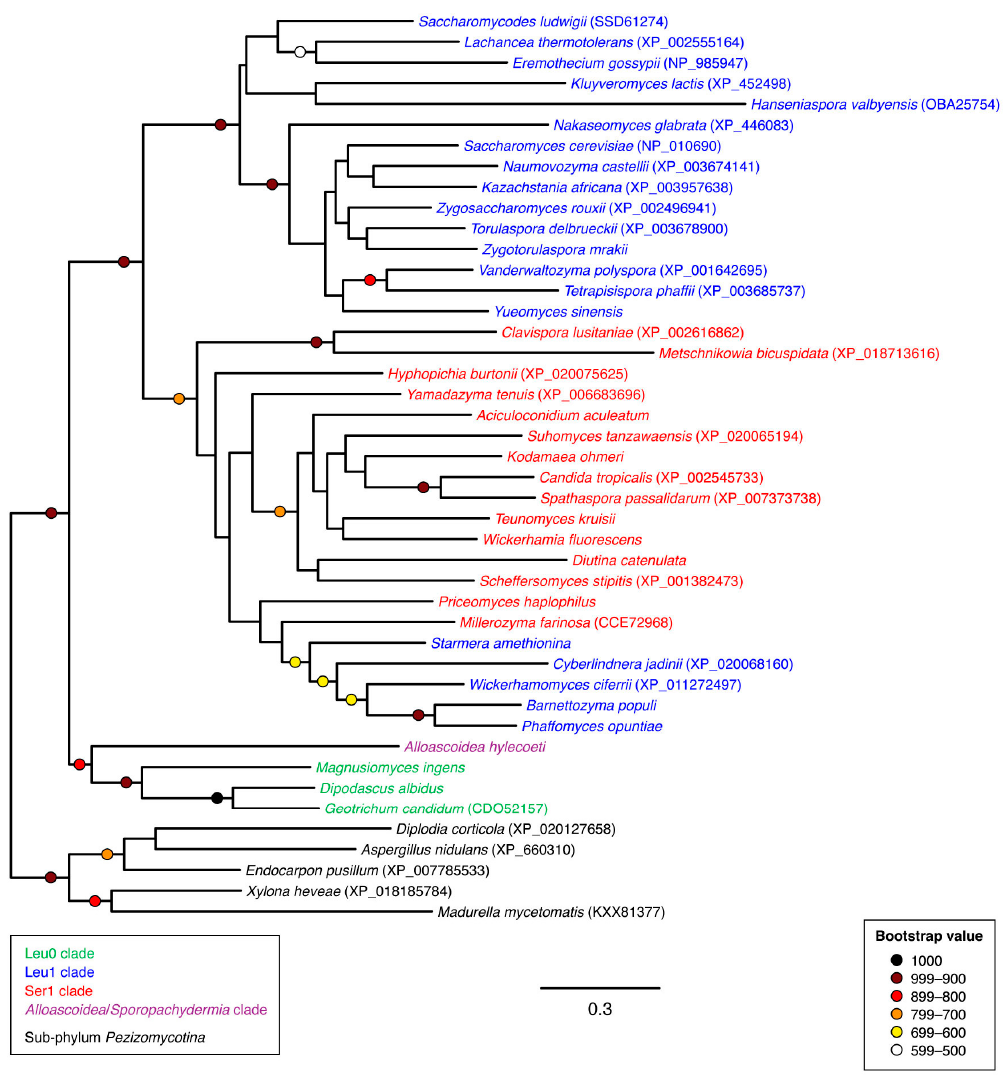
Figure 4. Unrooted phylogram of CYP56 gene products in representative species of sub-phylum Saccharomycotina as well as selected non- Saccharomycotina species. Individual species are color-coded with respect to clade [24]. The analysis was based on 327 aligned amino acid positions of the corresponding proteins. Colored circles represent branch support with the color indicating the proportion of retained nodes among 1000 bootstrap replicates. Branches lacking circles indicate branch support less than 500. Accession numbers for individual protein sequences are displayed when available. Protein sequences lacking accession numbers were derived through conceptual translation of genomic sequences. (Genomic coordinates for protein sequences derived through conceptual translation of genomic sequences are listed in Table A1 of Appendix A.).